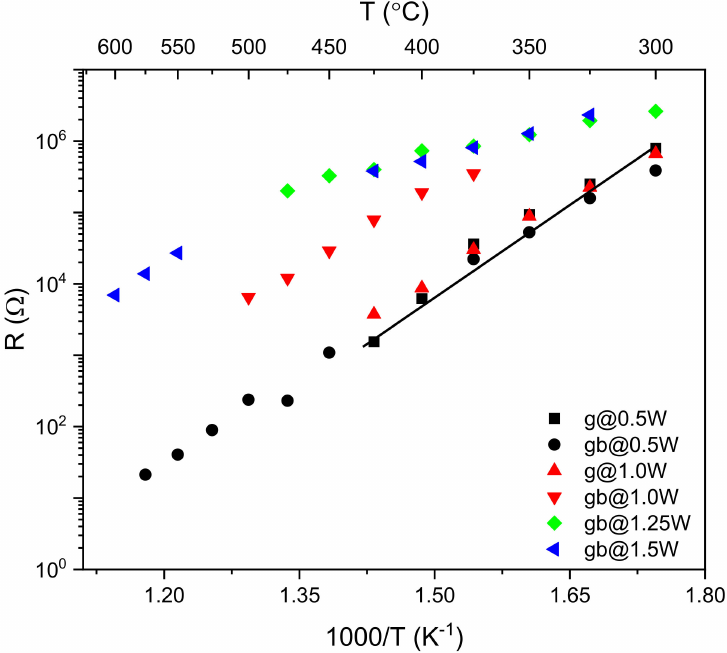
Figure 8. Reciprocal temperature dependence of resistances for P1 and P2 peaks for all the composi- tions. The solid line is the linear least-square fit. The fitting to other compositions are omitted for clarity. “g”: grain and “gb”: grain